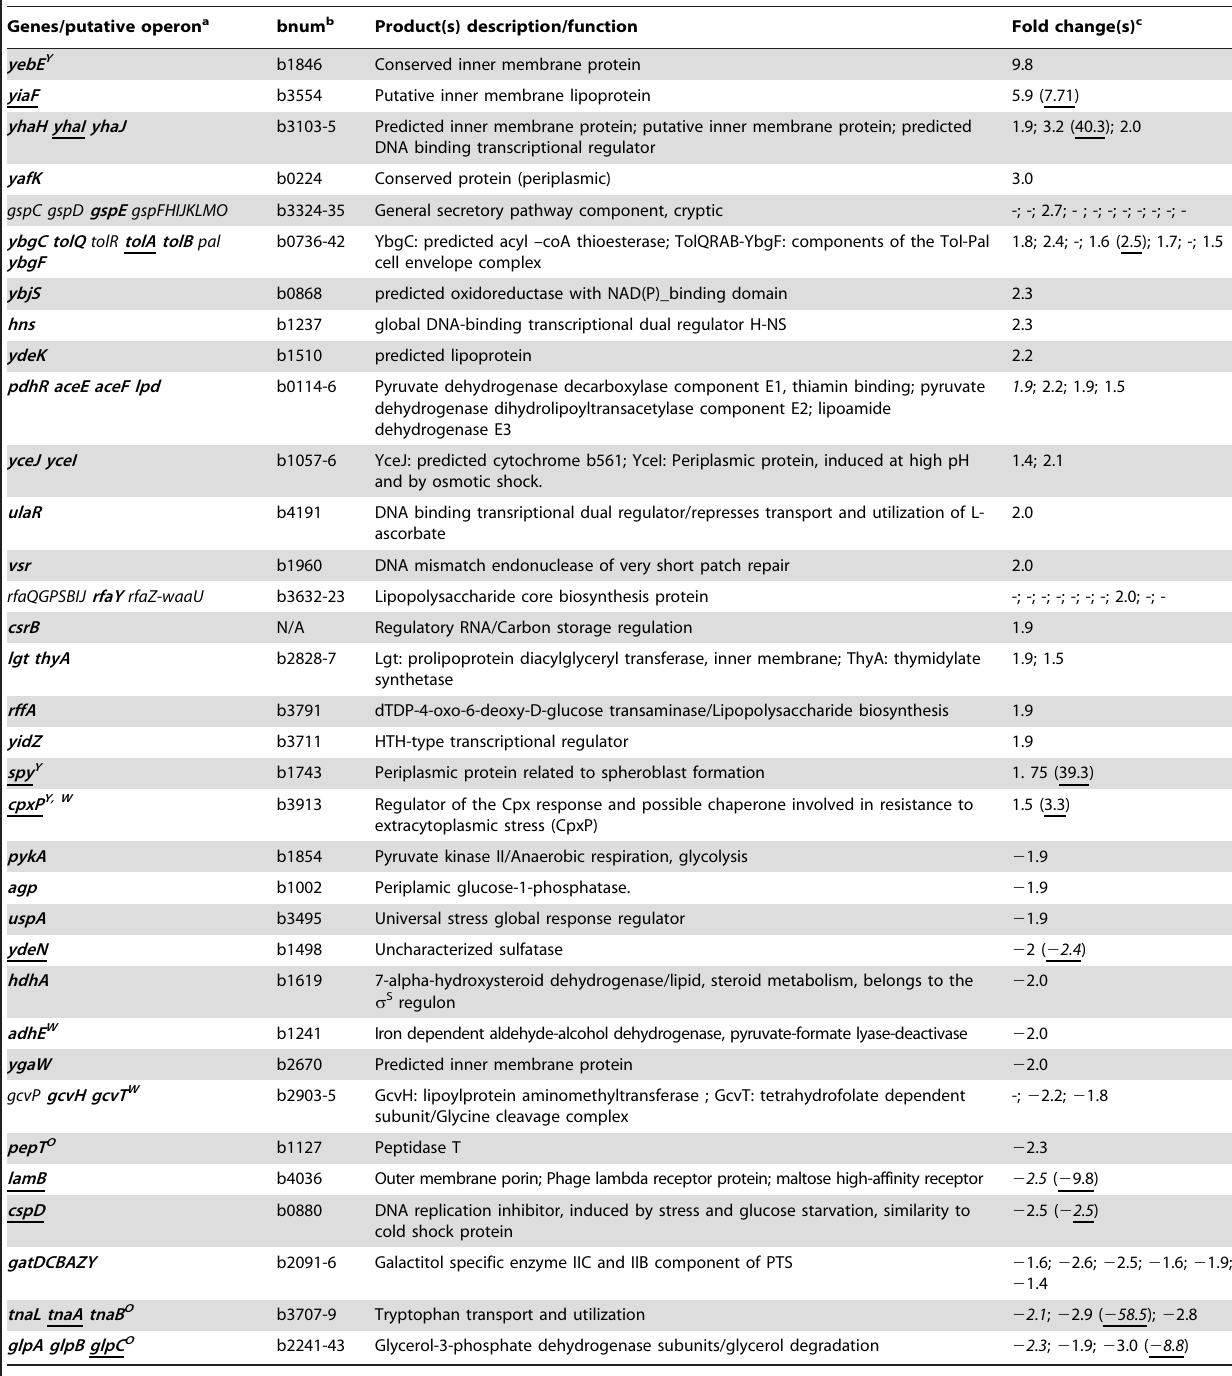
Table 6. Genes whose expression is significantly modulated by